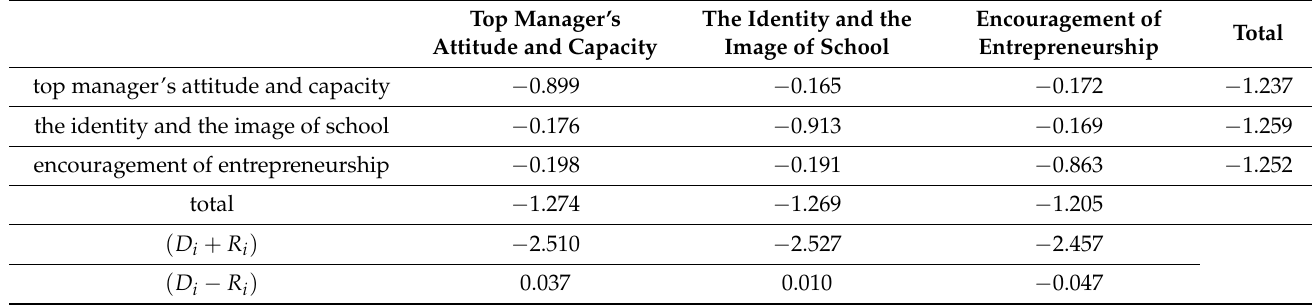
Table 3. The causal matrix of sub-aspects of organizational culture